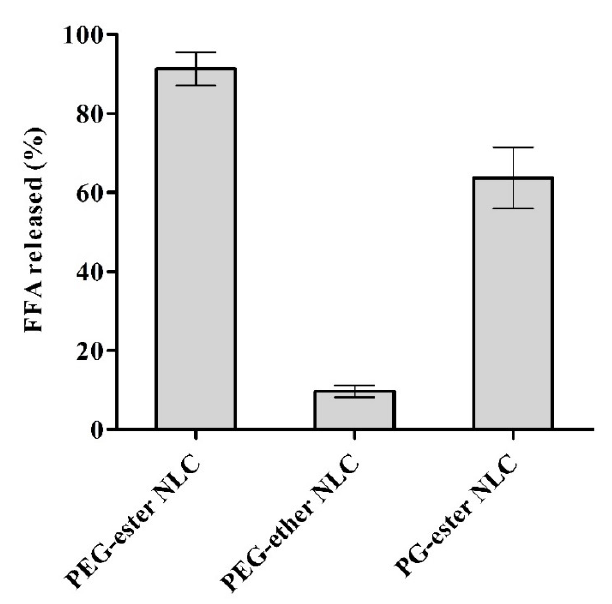
Figure 4. Percent free fatty acid (FFA) released from NLCs during lipolysis study for 60 min. Lipolysis was determined by the pH-stat titration method in lipid digestion buffer containing pancreatin at pH 7.5 and 37 °C. FFA release during the experiment was titrated with 0.5 M NaOH. Data are shown as means ± SD ( n = 3).